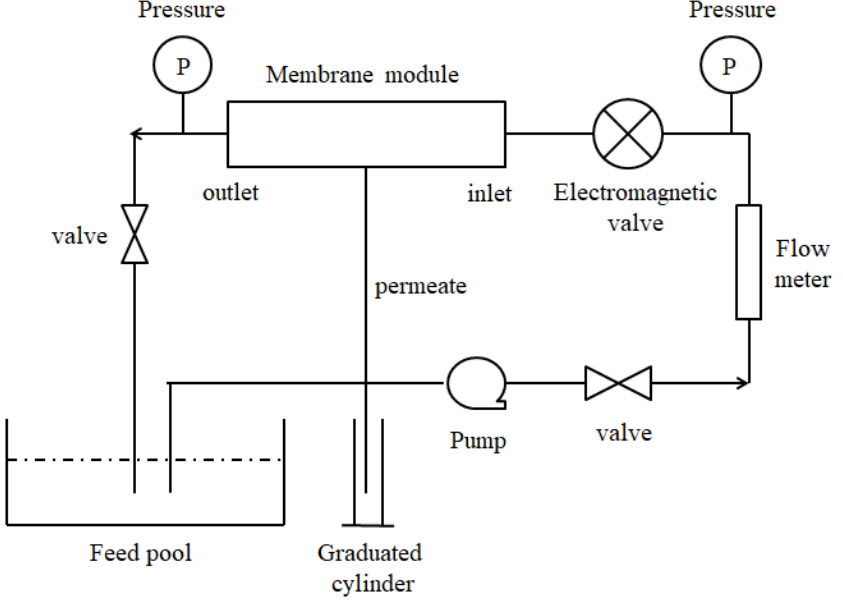
Figure 1. The cross-flow filter process diagram. The normalized specific flux J/J 0 was used to represent the membrane performance as a function of time, and J 0 represented the initial membrane flux. For the UF experiments, the humic acid (HA) solution was diluted with deionized water in the stirred feed pool. The UF permeate and concentrate were run back to the feed